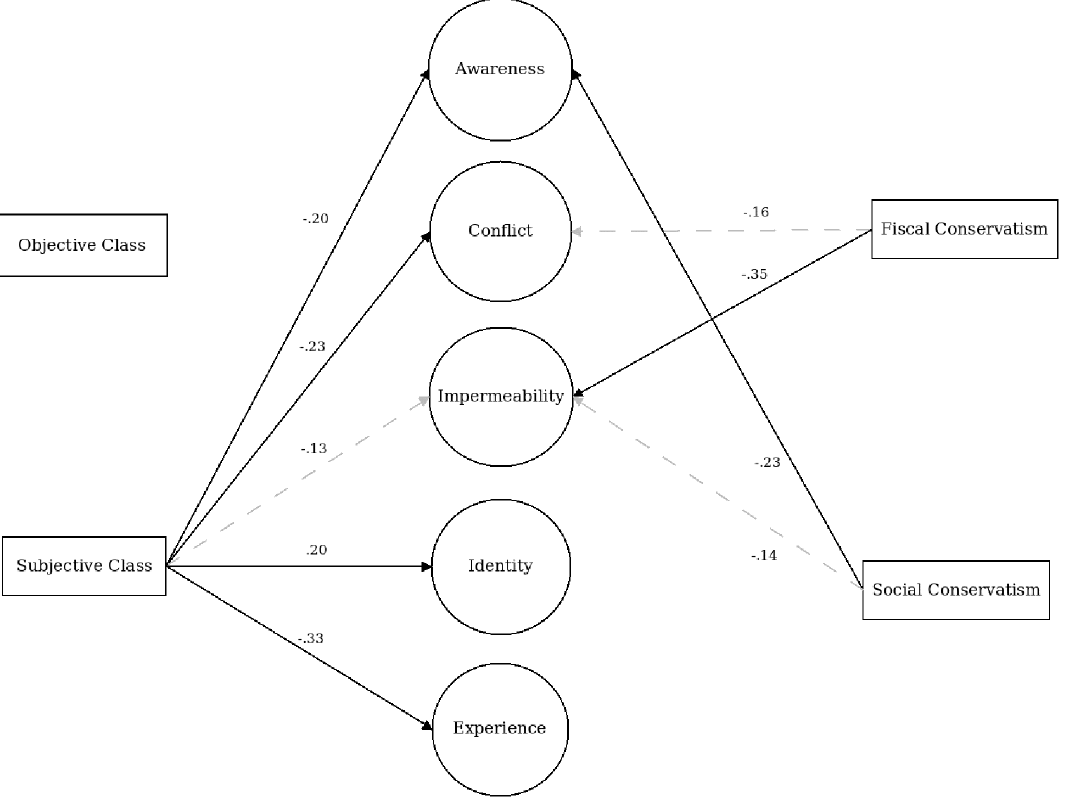
Figure 1. Associations between objective social class, subjective social class, and class consciousness. Note. Values are standardized path coefficients. Dashed paths are marginally significant at p < .10, solid paths are significant at p < .05. Age and gender are included in the model but are excluded from the figure for simplicity.